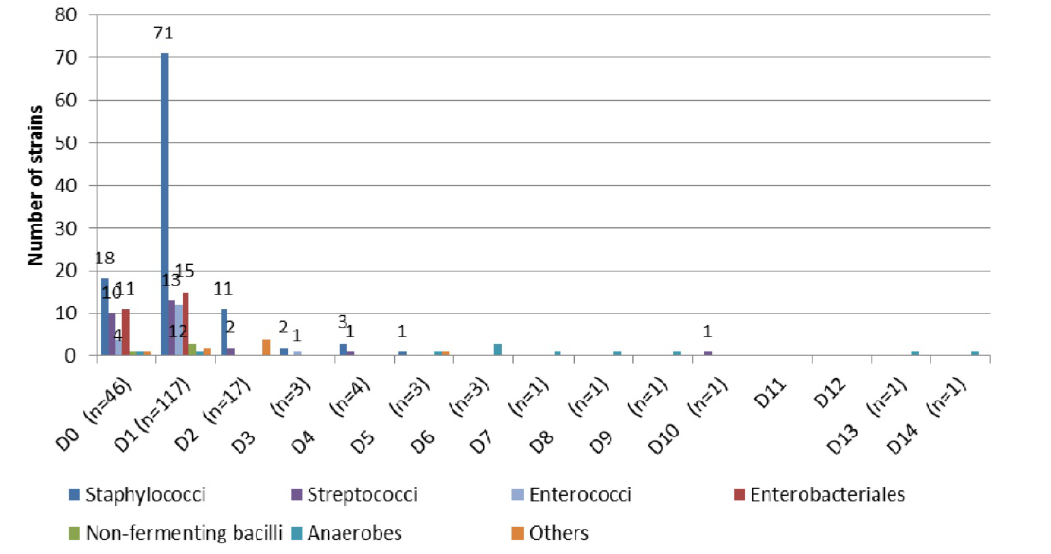
Figure 1. Time of positivity for the 199 strains